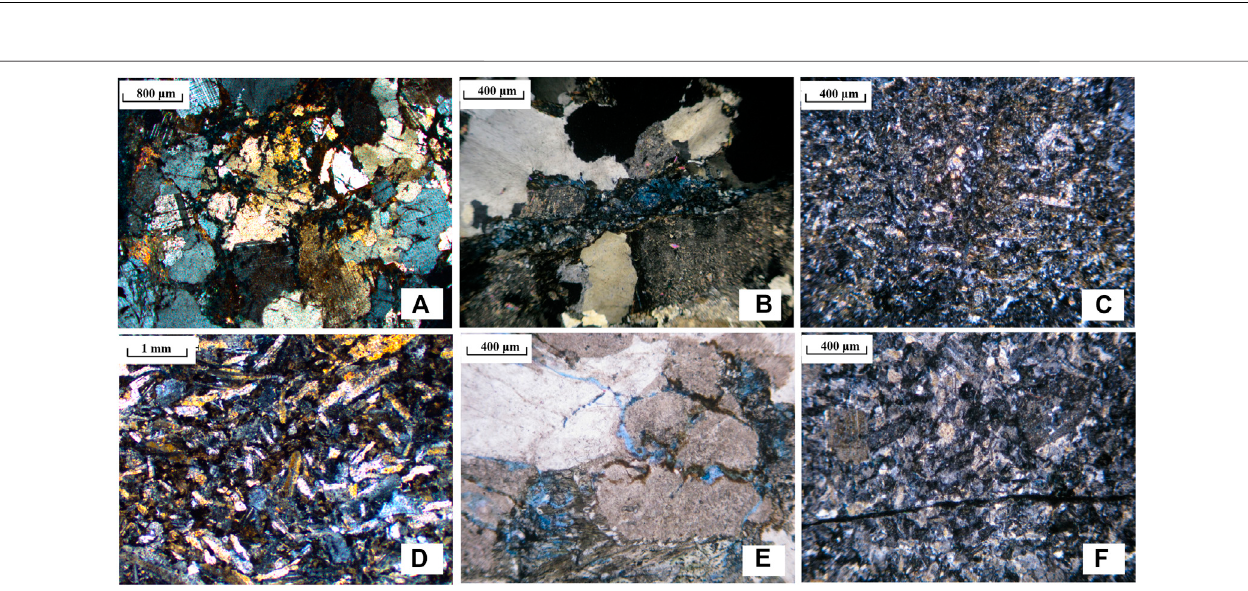
FIGURE2| BZ19-6-Awellrockchips. (A) Monzonitegneiss,3,925 m,perpendicularpolarizedlight; (B) Plagioclasegneiss,4,357 m,perpendicularpolarizedlight; (C) Altered andesite, 3,981.5 m, perpendicular polarized light; (D) Diorite porphyrite, 4,076 m, perpendicular polarized light; (E) Local dissolution joint, 4,254 m, plane polarized light; (F) Filling of iron dolomite and pyrite, 4,005 m, perpendicular polarized light.